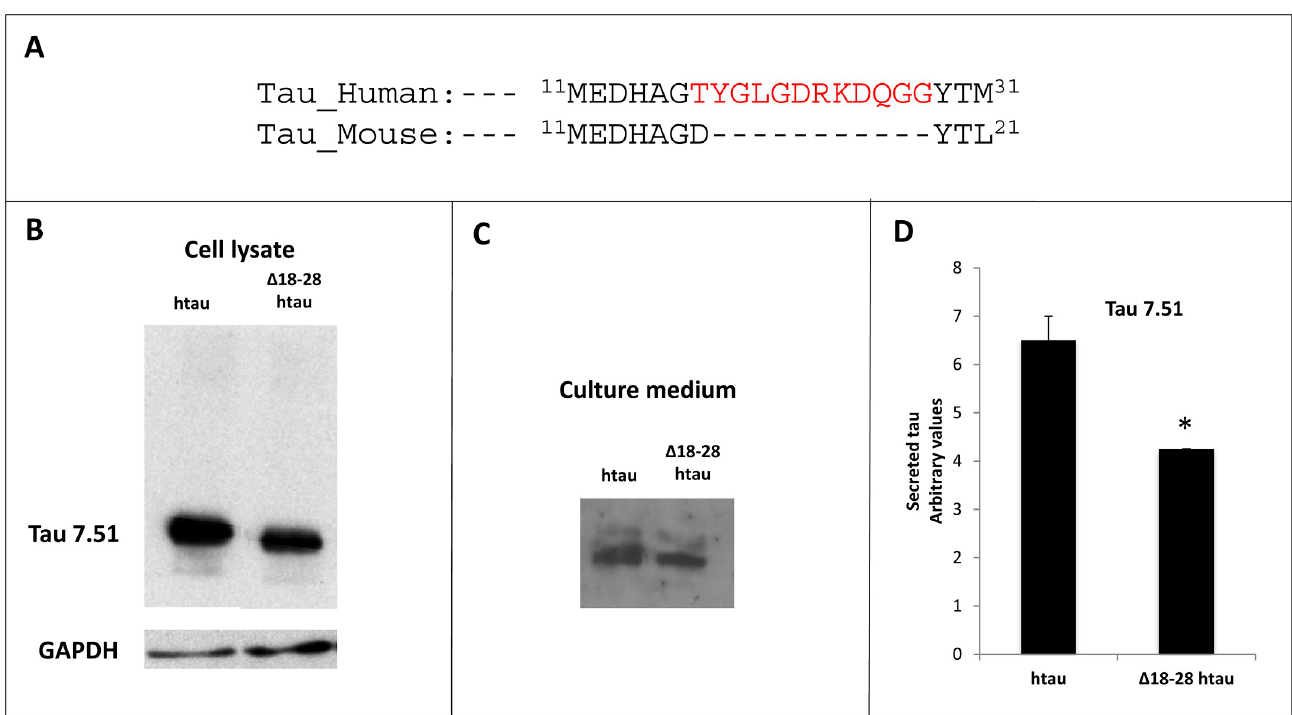
Fig 1. Expression of human and human tau- Δ 18–28 in COS-7 cells. A) Alignment of human and mouse tau sequences at the N-terminal domain. Mouse tau lacks the motif spanning residues 18–28 that is present in human tau. B) Expression of human and htau- Δ 18–28 in COS-7 cells. Tau expression was analyzed by Western blot using tau antibody 7.51. GADPH was used as loading control for cell lysates. C) Secreted tau levels from experiment 1B were analyzed by Western blot of cell culture medium. D) Densitometric quantitation of the extracellular tau from panel C. � P < 0.05.